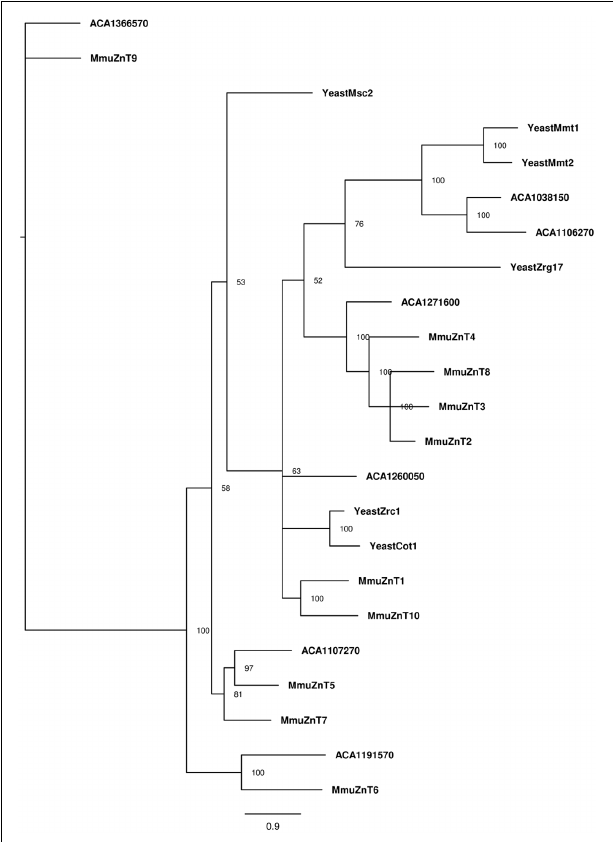
FIGURE 4 | Phylogenetic reconstruction of ZnT zinc proteins from mouse, amoeba, and S. cerevisiae . Sequences retrieved from Uniprot and AmoebaDB based on the presence of Pfam domain ZnT (PF01545) were aligned with Clustal Omega, and the best evolutionary model was selected based on ProtTest. Bayesian analysis was conducted and the tree was drawn using FigTree. The percentage of replicate trees in which the associated taxa is shown next to the branches. The scale bar represents substitutions of amino acids per